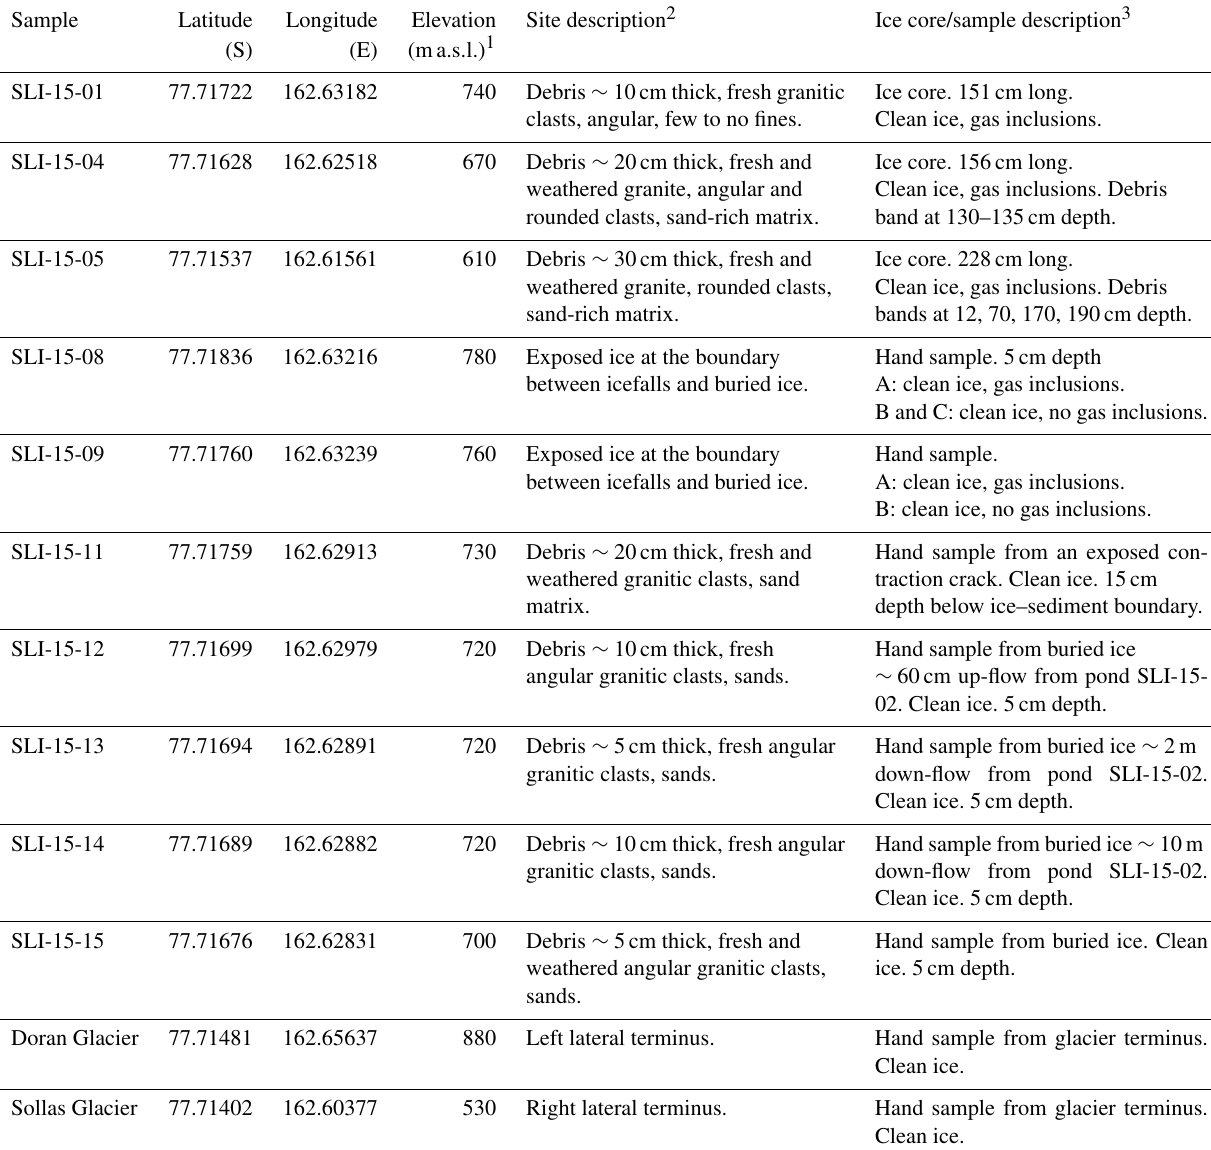
Table 1. Alpine glacier and rock glacier ice sample descriptions.